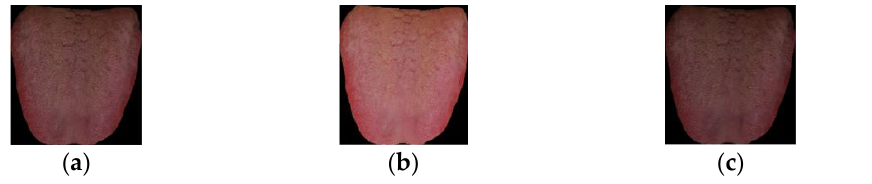
Figure 4. This is the tongue image in three different brightness levels. ( a ) Original image; ( b ) tongue when brightness adjustment factor k = 0.5; ( c ) tongue when brightness adjustment factor k = 1.5.